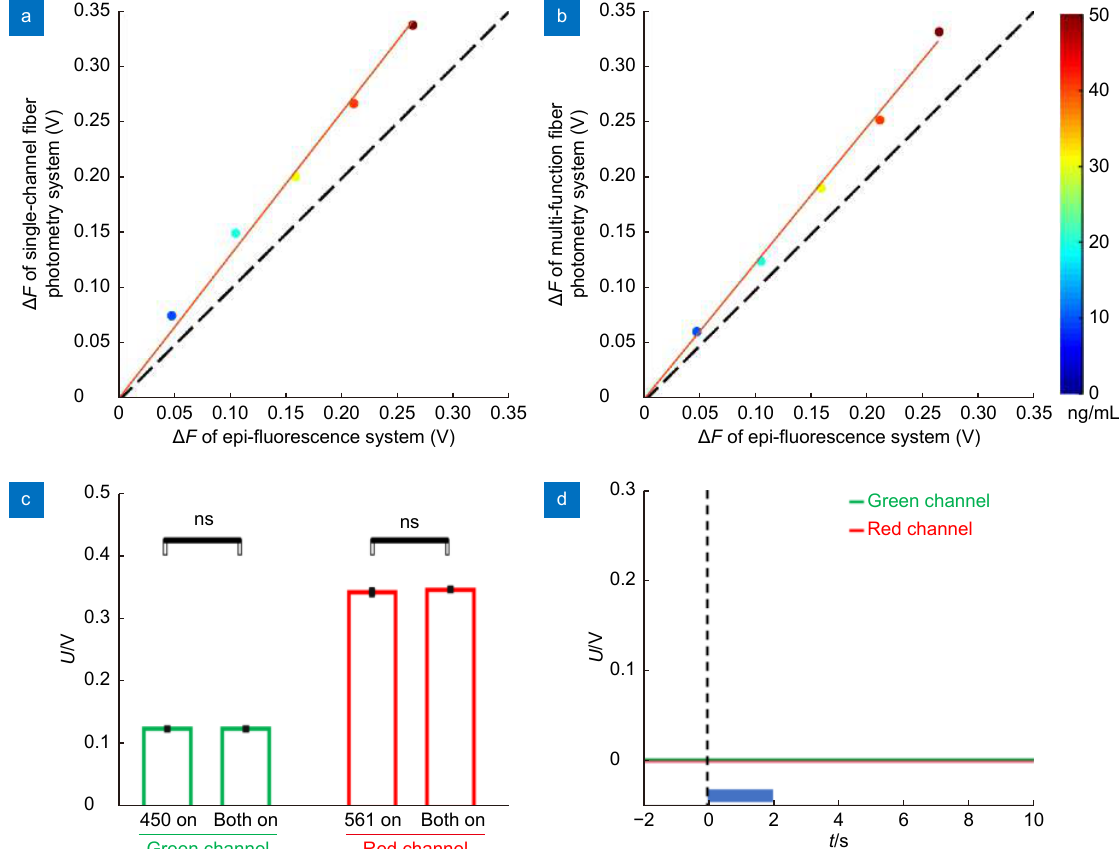
Fig. 3 | Evaluation of the light transmission performance of the all-fiber-transmission photometry system. ( a , b ) The fitting curve of the fluorescence intensity variation of a traditional epi-fluorescence system with the all-fiber-transmission photometry system based on the bifurcated fiber bundle (a) or the four-branch fiber bundle (b). The dashed line represents the curve for y = x . The red line represents the fitting curve for the single-channel fiber photometry system ( f ( x ) = 1.297 x , R-square: 0.9938) and the multi-function fiber photometry system ( f ( x ) = 1.233 x , R-square: 0.9982). ( c ) The mean fluorescence intensity of the green (450 on: 0.1254 ± 0.0003; both on: 0.1257 ± 0.0004) and red (561 on: 0.3421 ± 0.0069; both on: 0.3456 ± 0.0059) channel between the other excitation light “off” and “on”. P >0.05, Wilcoxon’s signed-rank test; n = 7 pairs. ( d ) No signi- ficant stimulation artifacts are detected in the green and red channels of the all-fiber-transmission photometry system when applying a 660-nm laser stimulation ( P >0.05, Wilcoxon’s signed-rank test; n = 10 pairs). The blue bar indicates the time of